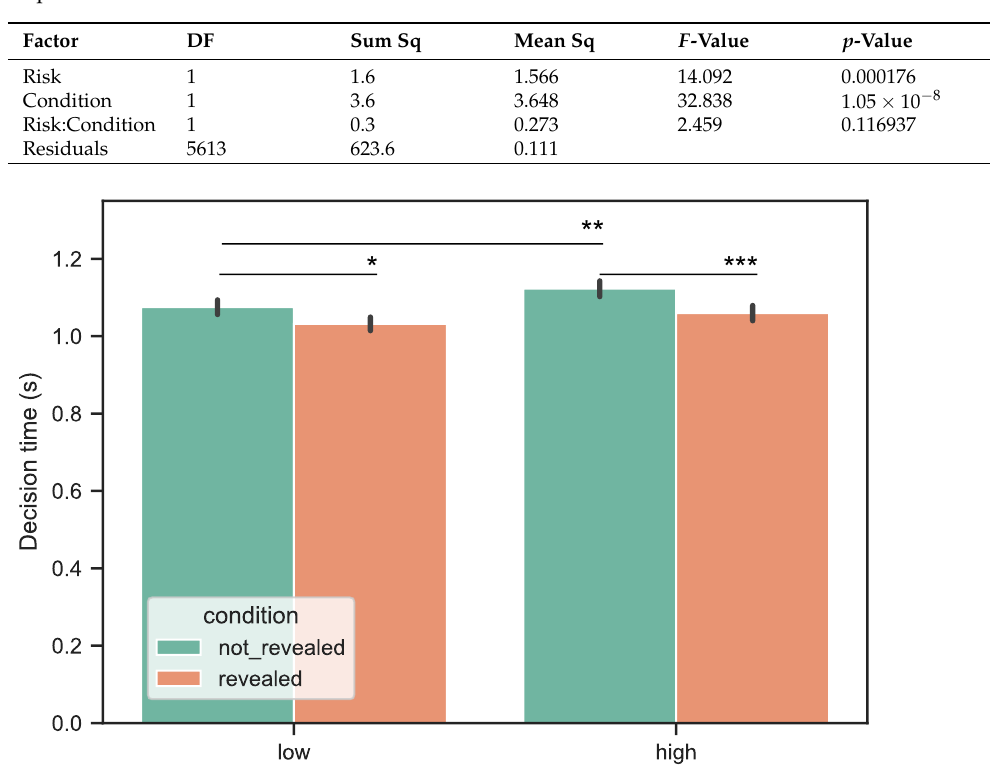
Table 3. The summary table for ANOVA results for the decision time. DF is degrees of freedom, Sum Sq contains values for the sum of squares, Mean Sq are mean squares, and F - and p -values are respective ANOVA statistics values.